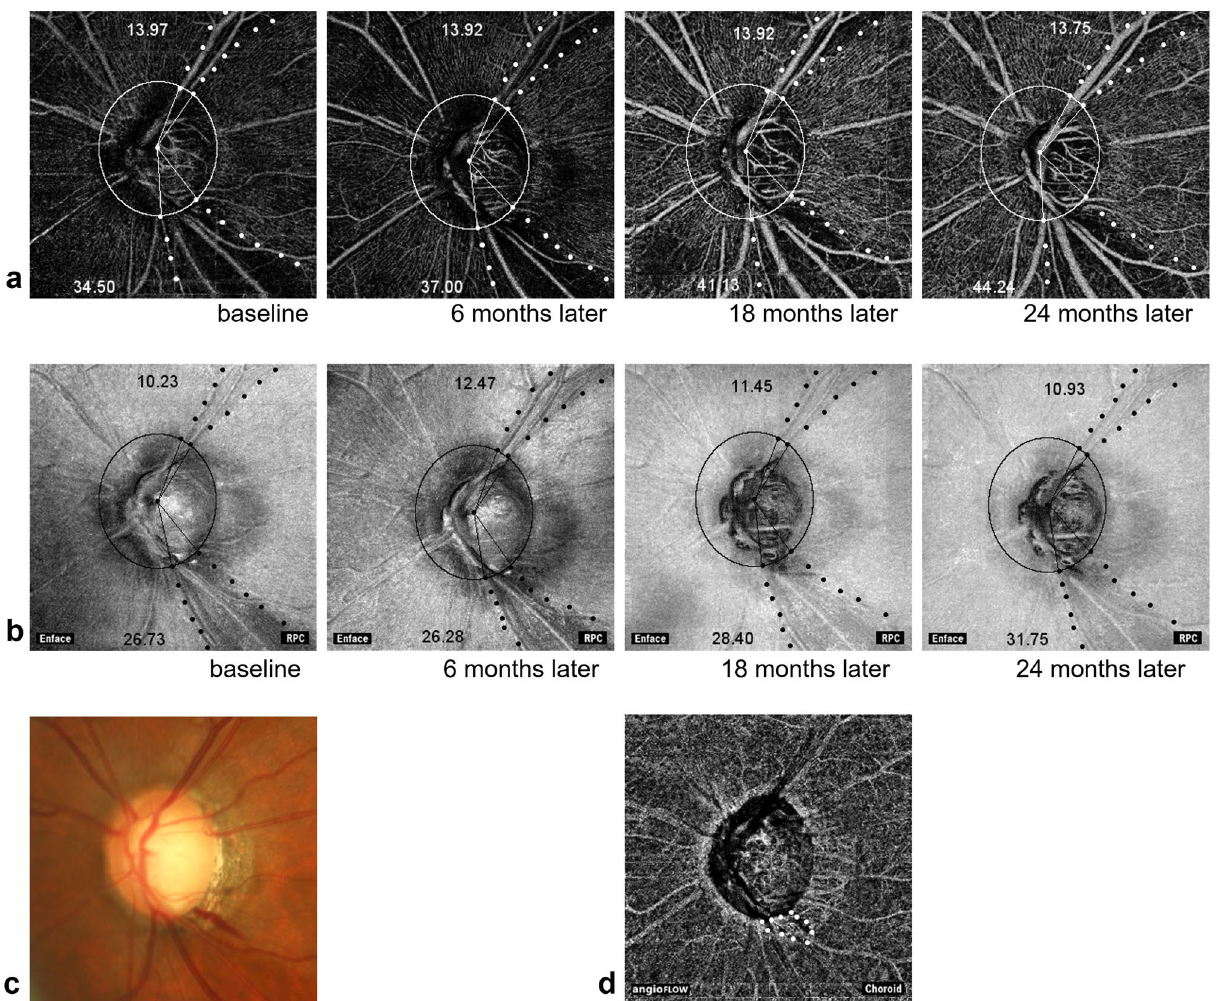
Figure 3. Representative images on longitudinal OCTA examination of a glaucomatous eye. ( a ) OCTA images obtained at the inner retinal layer show the longitudinal changes in deMv-angle of a 73-year-old man. Inferotemporal NFLD had 13 episodes of DH. Superotemporal NFLD had no DH episode. The numbers in the figure represent the angles of deMv in each NFLD. The deMv-angle of the inferotemporal NFLD changes more than the superotemporal one. ( b ) OCT en face images show the longitudinal changes in NFLD of the same eye. The numbers in the figure represent the angles of NFLD. The angle of inferotemporal NFLD changes more than the superotemporal one. RPC = Radial peripapillary capillary. ( c ) Disc photograph at baseline shows disc hemorrhage in inferotemporal NFLD. ( d ) Choroidal OCTA image of the same eye showing choroidal microvascular dropout (white dotted